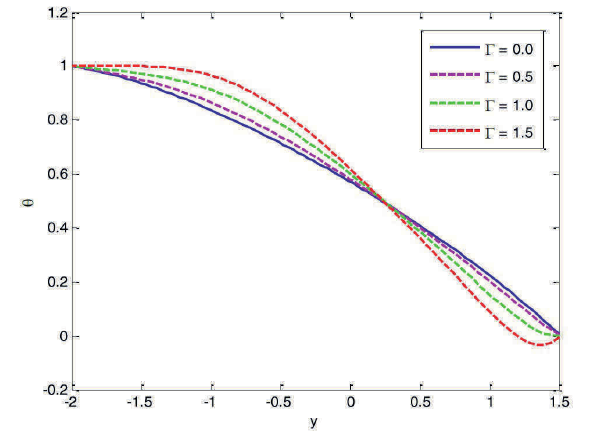
Fig. 10: Impact of Hartmann number Ha on temperature.